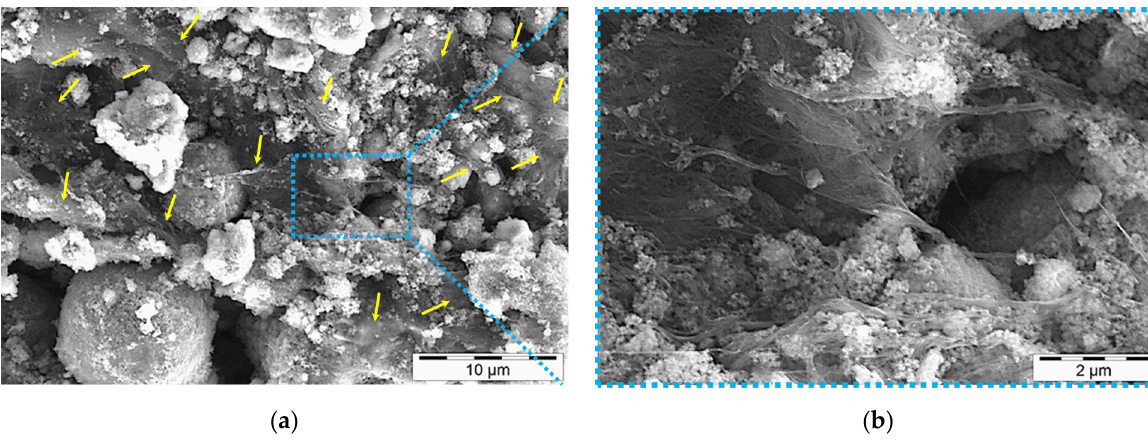
Figure 7. SWCNTs’ electrically conductive network generated in 3-day one-part SWCNT-alkali-activated nanocomposites, SWCNT conc. 1.0 wt.%. SWCNT agglomerates constituting the network are marked with yellow arrows. ( b ) is the higher magnification of the selected zone in ( a ), shown by a dot blue box.